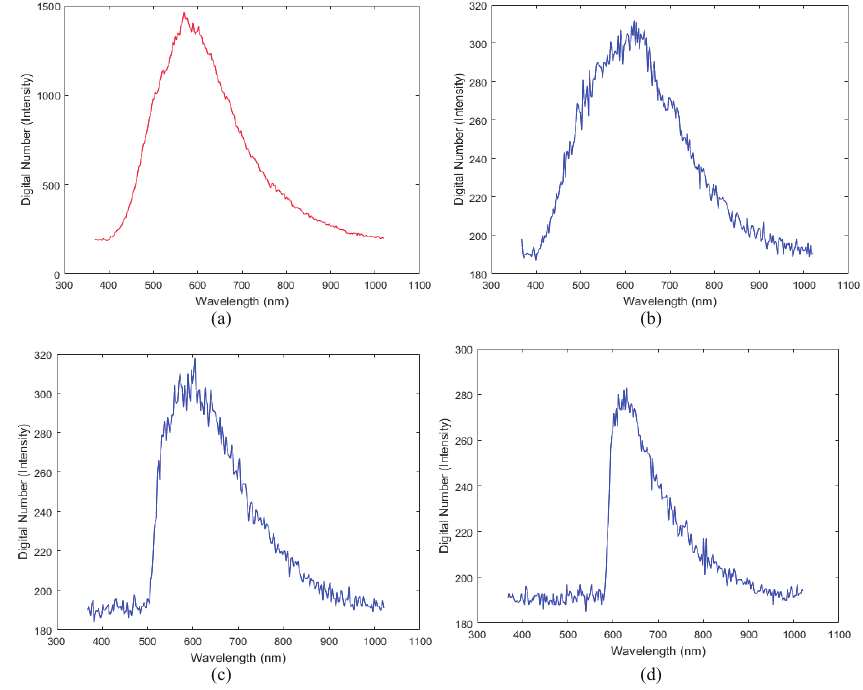
Figure 13. Spectral information of a halogen lamp and reflection: ( a ) halogen lamp spectra ( b ) white reflection spectra, ( c ) yellow reflection spectra, and ( d ) red reflection